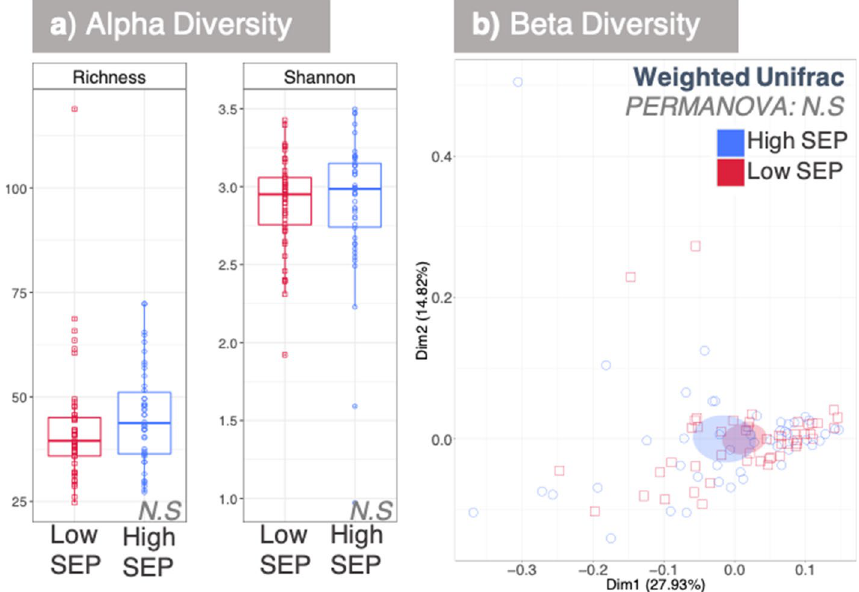
Figure 2. Microbial diversity analysis between high and low SEP. ( a ) and ( b ) represent alpha diversity and beta diversity indices, respectively. In ( b ), the ellipses are drawn at 95% confidence interval of standard